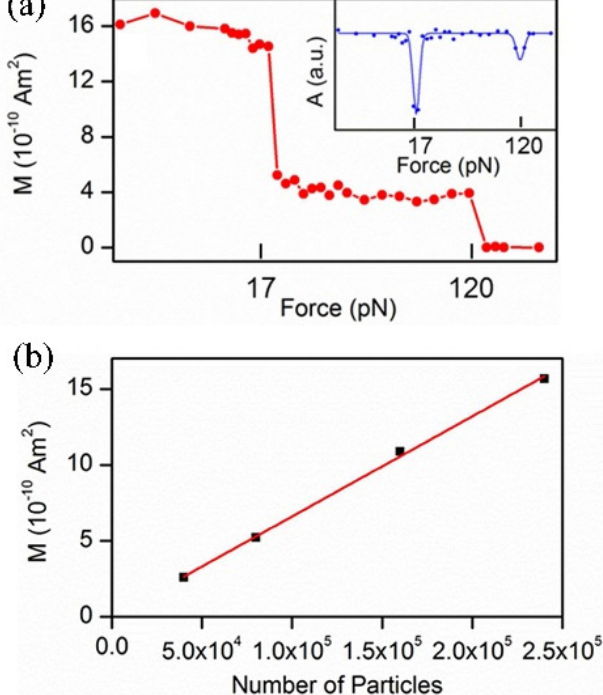
Figure 2. ( a ) FIRMS measurement of noncovalent antibody–antigen bonds, showing the relationship between the magnetization signal and applied force, and the ( b ) calibration for the number of magnet- ically labeled molecules, showing the linear correlation between the magnetization and the number of various magnetic probes [25]. Reproduced with permission from American Chemical Society.